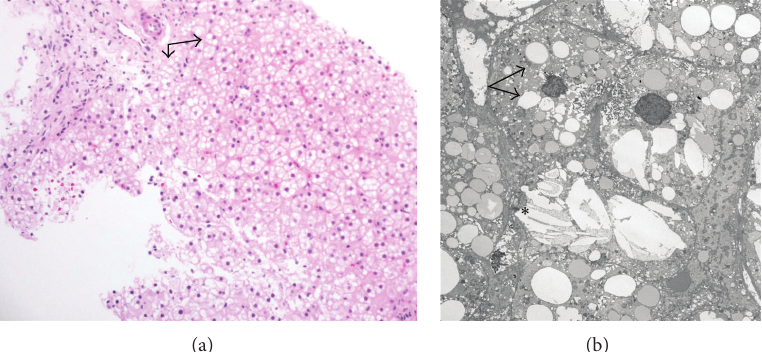
Figure 2: (a) Liver biopsy, periodic acid-Schiff stain with diastase (magnification, × 40). Lipid demonstrated within the hepatocellular cytoplasm (arrows). (b) Electron micrograph (direct magnification, × 2500). The hepatocellular cytoplasm in places has a moth-eaten appearance with lipid droplets (arrows). Additionally, some foci show cholesterol crystals ( ∗ ) free in the hepatocellular